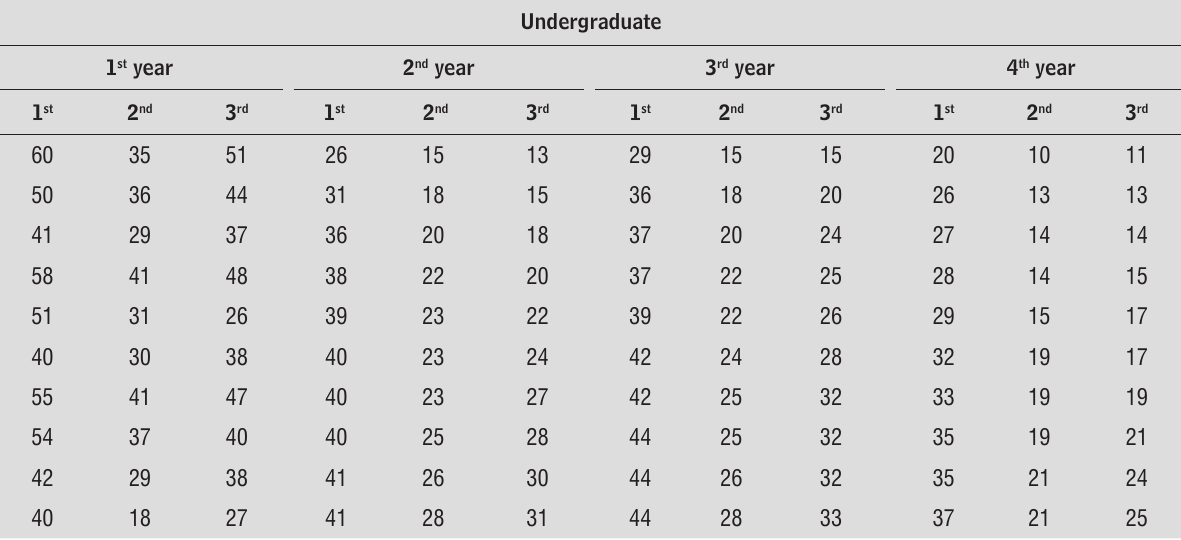
Table 1 - Raw data distribution per dimension in each